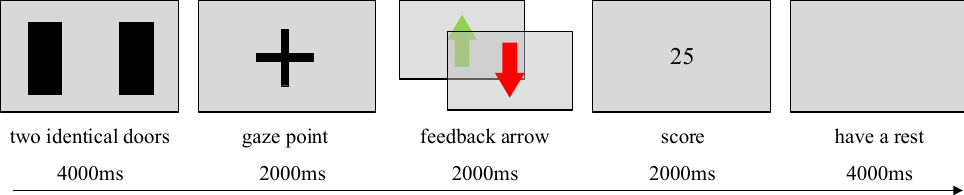
Figure 2. Single ‐ trial flow is as follows. Two identical doors would appear simultaneously on the computer screen, one corresponding to a win (+USD 2.0) and the other to a loss ( − USD 1.0). Subjects were instructed beforehand to always choose the door they thought would win money using an MRI ‐ compatible response box. The computer would randomly select a door if the subject did not make a timely choice. A 2000 ms gaze point and a 2000 ms feedback arrow came afterward. A green up arrow indicated a win, and a red down arrow a loss. At the end of the arrow feedback, the center of the screen would display the subject’s current cumulative score. After each trial, subjects were given a 4000 ms